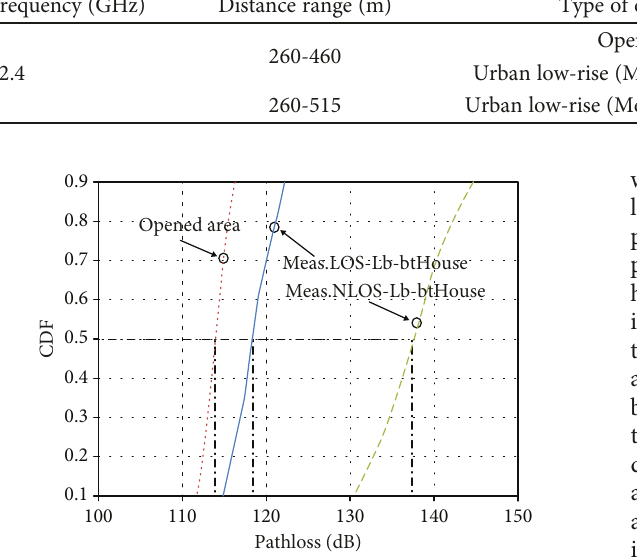
Figure 10: CDF on a path coming from inter-house space (at site- speci fi c).